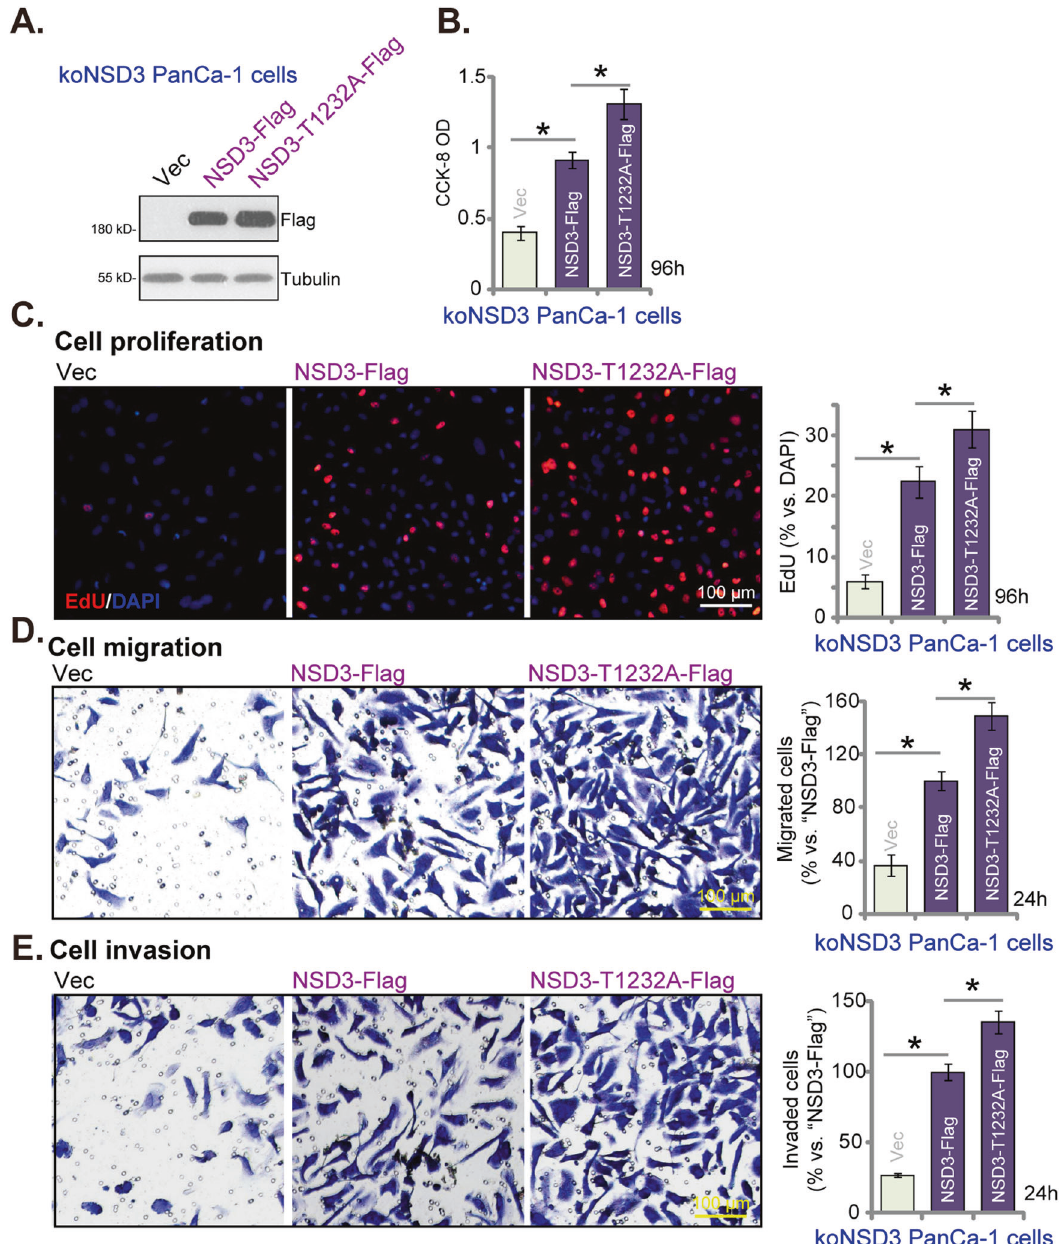
Fig. 5 NSD3-T1232A accelerates pancreatic cancer cell proliferation, migration and invasion. Single stable PanCa-1 primary pancreatic cancer cells bearing the lenti-CRISPR/Cas9 construct encoding NSD3 sgRNA ( “ koNSD3 ” ) were further transduced with NSD3-T1232A-Flag construct, the wild-type NSD3-Flag construct or empty vector ( “ Vec ” ); Expression of listed proteins was examined by western blotting assays ( A ). Cells were further cultured for applied time periods, cell viability (CCK-8 assays, B ), proliferation (EdU staining assays, C ), cell migration ( “ Transwell ” assays, D ), and invasion ( “ Matrigel Transwell ” assays, E ) were tested. Data were presented as mean ± standard deviation (SD, n = 5). * P < 0.05. Experiments in this fi gure were repeated fi ve times with similar results obtained. Scale bar = 100 μ m ( C – E migration, and invasion. Cell cycle arrest and apoptosis were detected in NSD3-silenced pancreatic cancer cells. Moreover, CRISPR/Cas9-induced complete NSD3 KO inhibited pancreatic cancer cell growth and induced signi fi cant apoptosis activation. Conversely, ectopic expression of the mutant and constitutively active NSD3 (T1232A) accelerated pancreatic cancer cell prolifera- tion, migration, and invasion. In vivo, NSD3 shRNA AAV injection potently inhibited PanCa-1 xenograft tumor growth in nude mice. These results implied that NSD3 could be a novel oncogenic gene and therapeutic target for pancreatic cancer.